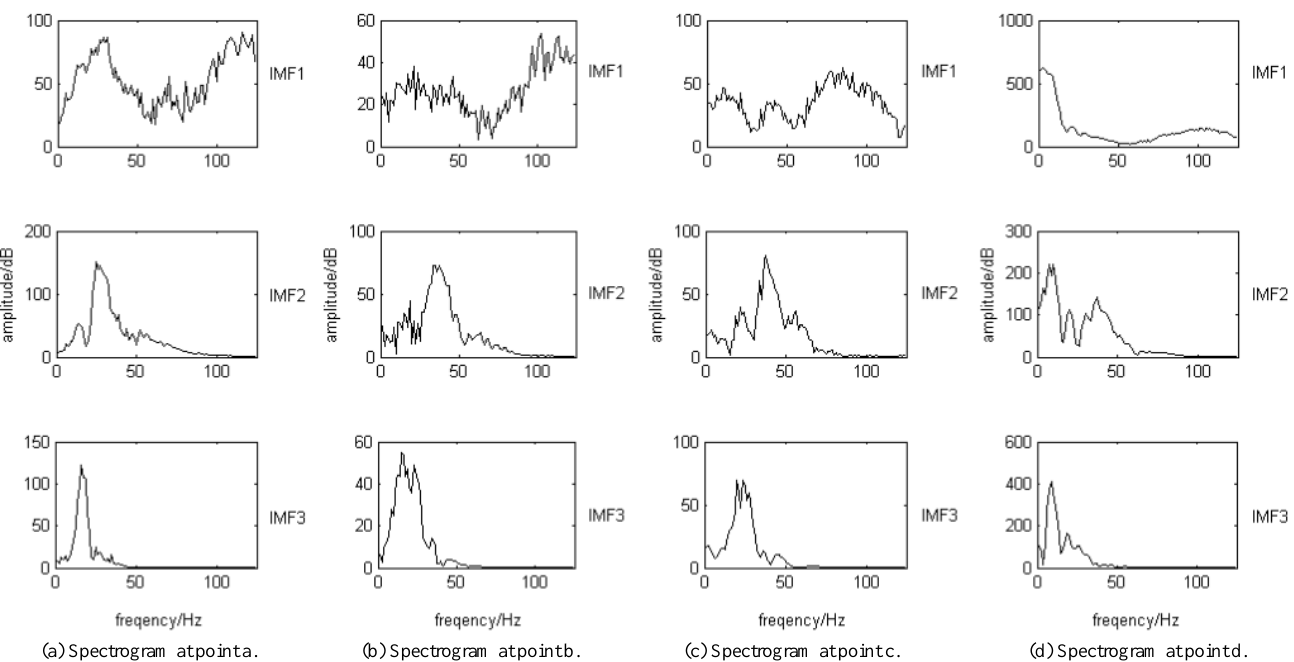
Figure 8. Spectrum of the first 3 components of signals at the impact point a, b, c, d using whitening EMD